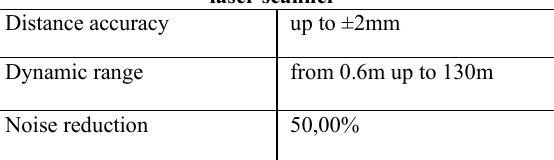
Table 1 . Technical specifications of the "Faro focus 3d X 120" laser